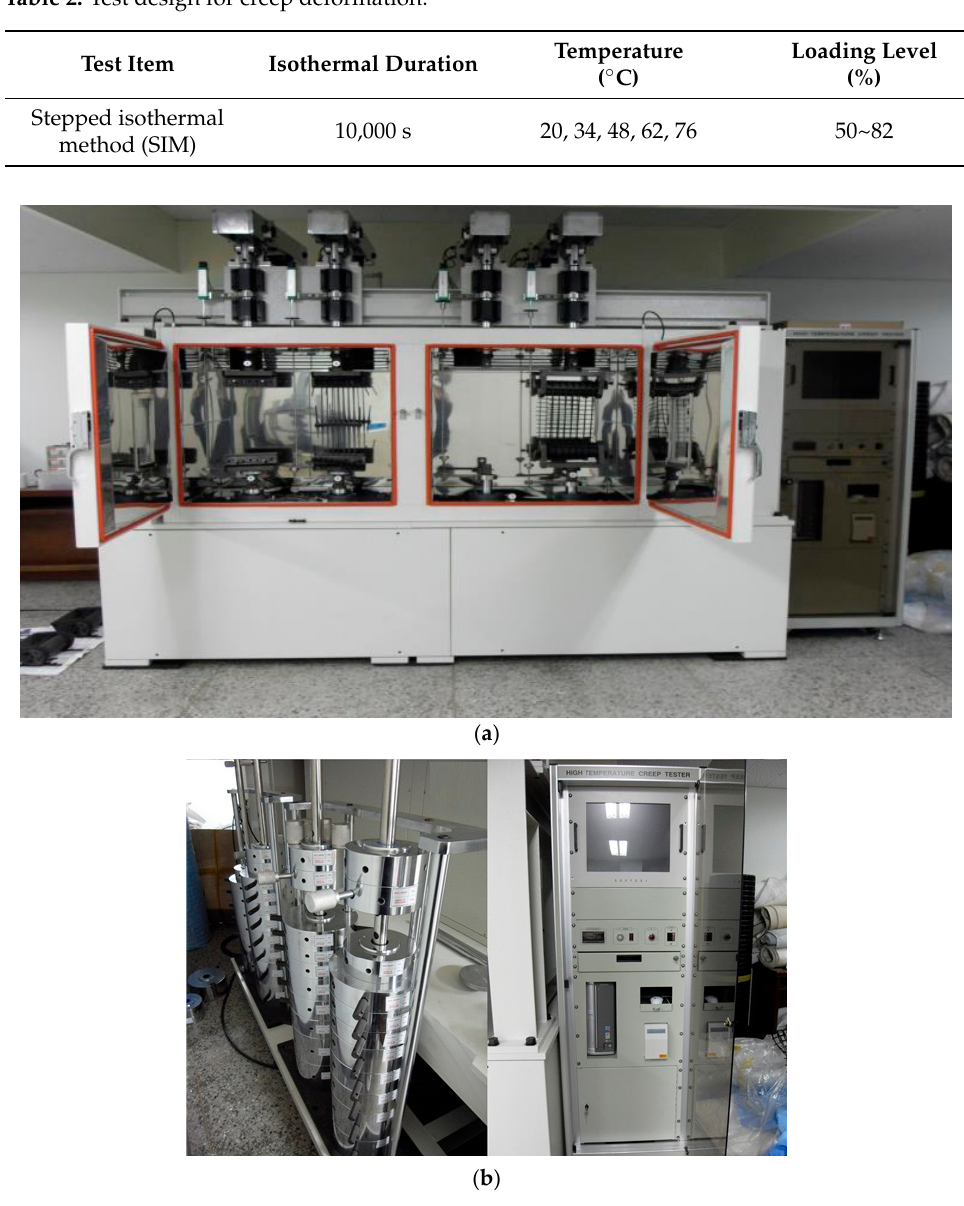
Figure 2. Photographs of creep test apparatus for SIM. ( a ) Creep test apparatus; ( b ) Loading system ( left ) and control system ( right ).